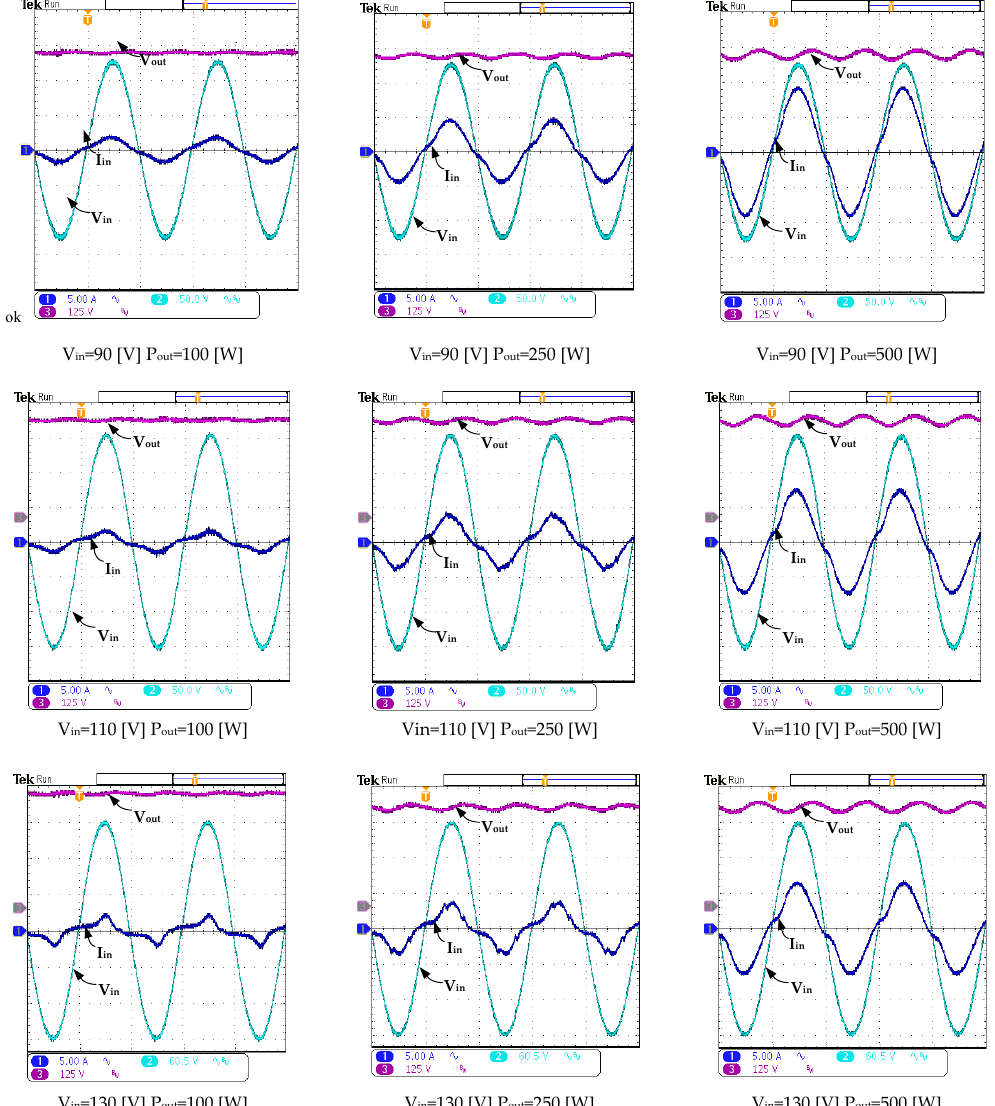
Figure 12. Practical measurements of the proposed converter at different input voltages and differ- ent output powers. V in —main input voltage; V out —DC output voltage and I in input current.